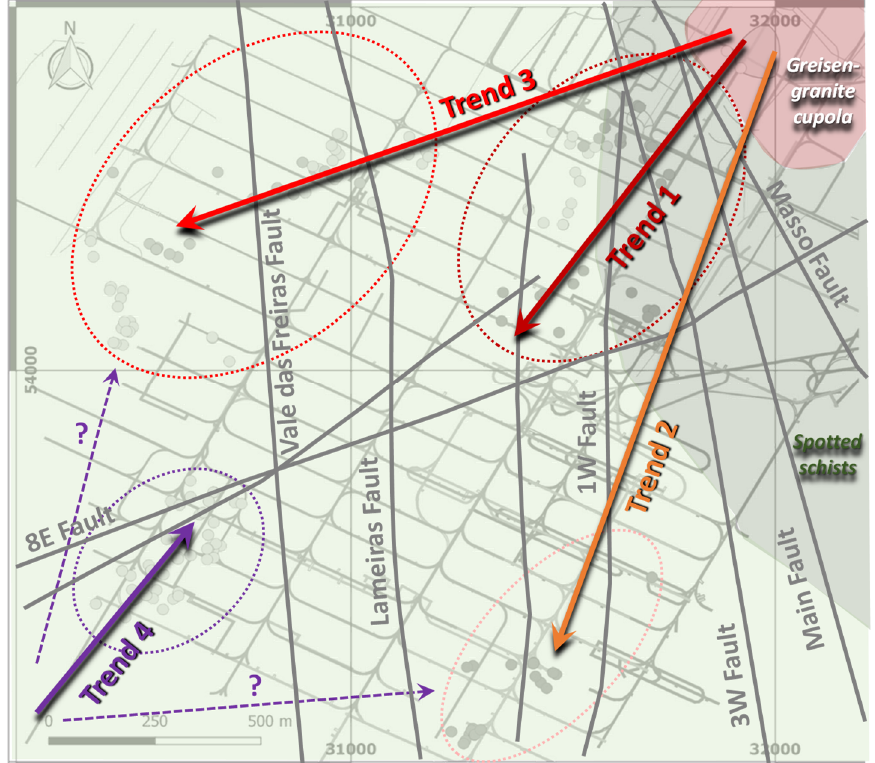
Figure 12. Schematic illustration of the geological trends at the mine scale discussed in the text, using as the background the simplified map shown in Figure 2. Dashed ellipses encircle different sample sets (see Figure 3 for details).